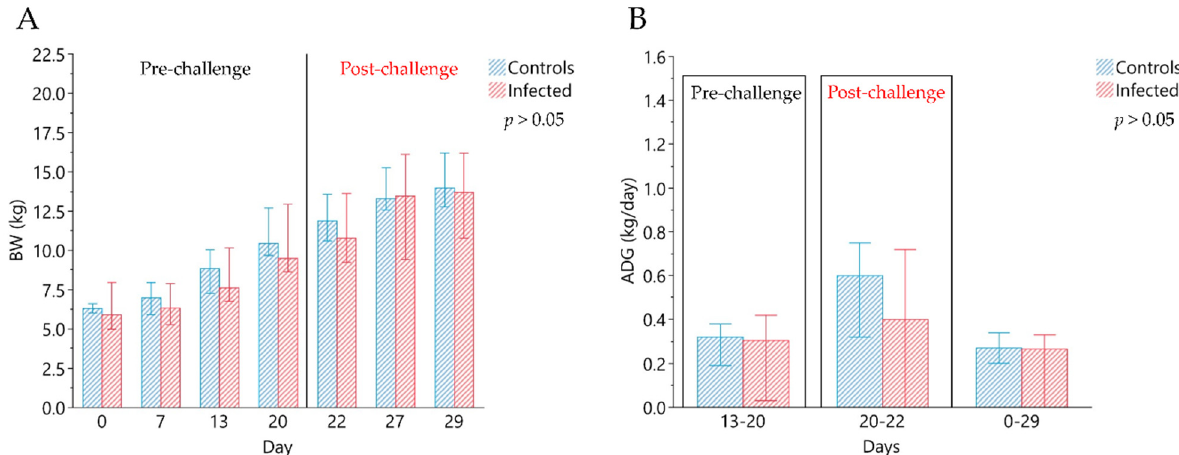
Figure 1. Evaluation of zootechnical performance. ( A ) Median values of individual body weight (kg) of experimental groups, measured at 0, 7, 13, 20, 27 and 29 days. Day 0 corresponds to the beginning of the in vivo trial, and day 20, indicated by the line, correspond to the day of infection. ( B ) Median values of average individual daily gain (ADG) in the experimental groups. ADG (13–20) indicates the average daily gain calculated in the pre-infection period: from day 13 to day 20; ADG (20–22) represents the average daily gain in the first period after infection (from day 20 to day 22; at day 20 was performed the experimental infection); ADG (0–29) is the average daily gain calculated in the entire experimental period (from day 0 to day 29). The comparisons were performed using the Wilcoxon Rank Sum test for independent groups. All data are reported as medians, minimum (min) and maximum (max) of results obtained for the pigs in the Control ( n = 6) and in the Infected ( n = 12) groups.